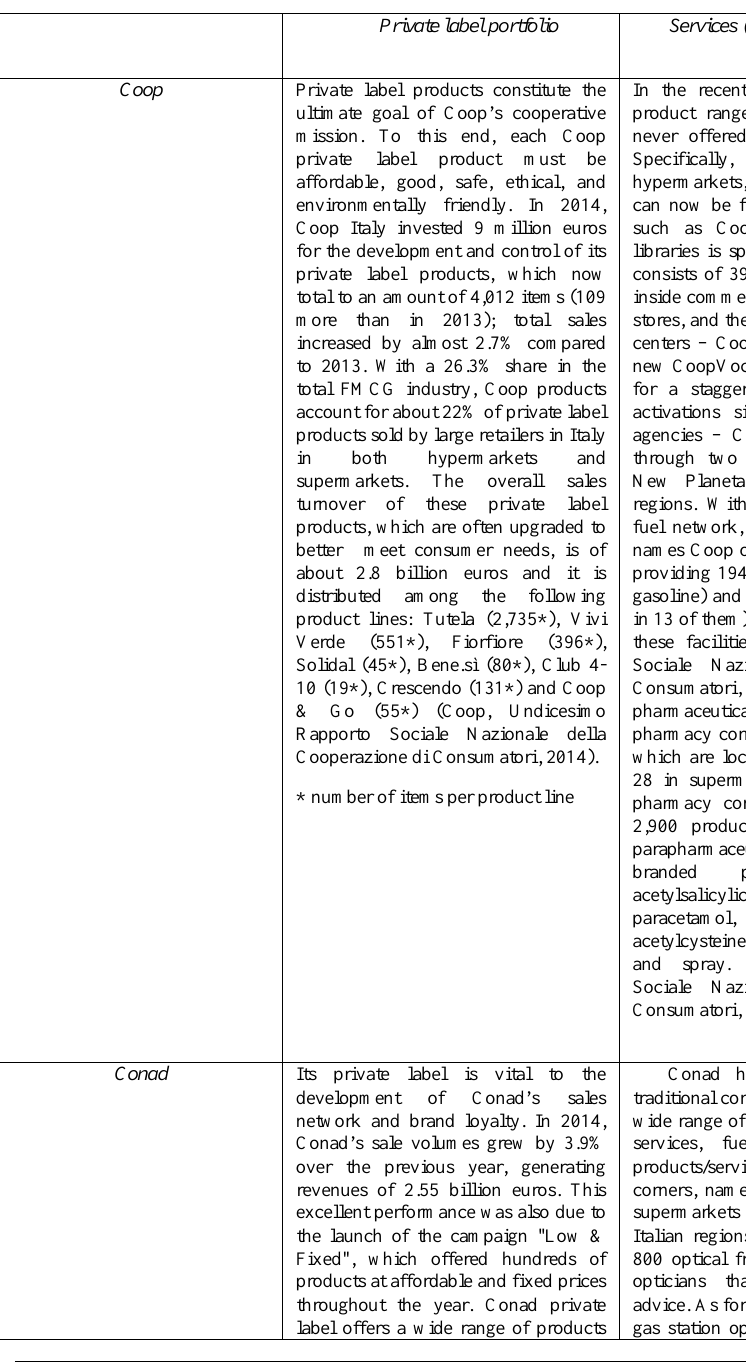
Table 6: Private Label Portfolio Services 7 of the Three Largest Italian Retailers Ranked by